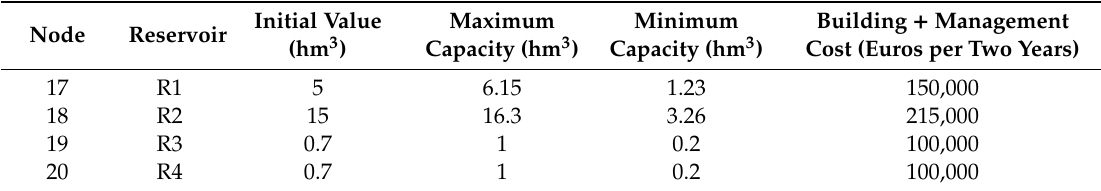
Table 4. Reservoir characteristics considered in the LP-model.